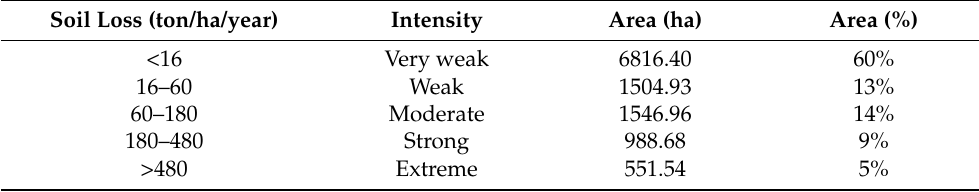
Table 4. Classification of soil loss rate in the Rongga Sub-district landscape.